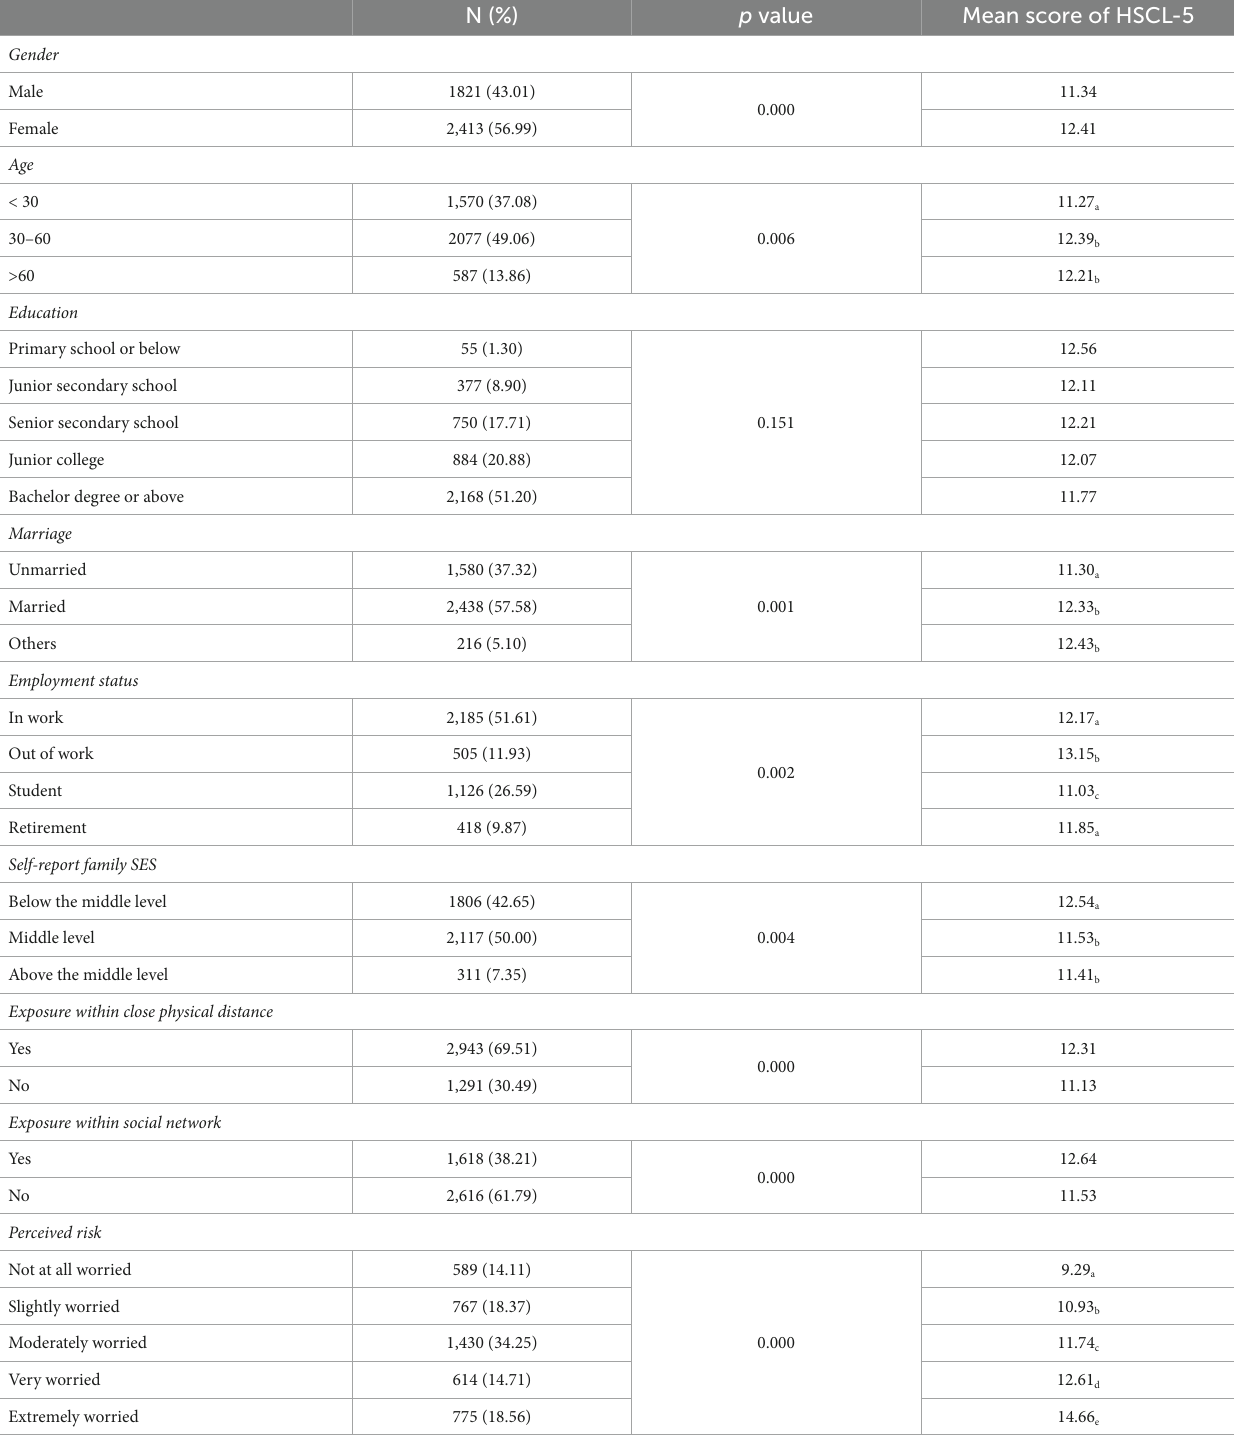
p -values in the third column were obtained by T -test (for binary variables: gender and two exposure factors) and ANOVA (for multinomial variables). Subscripted lowercase letters (a, b, c, d, e) in the fourth column represented the results of pairwise comparisons of the mean total score of HSCL-5. The same letters meant that the difference between any two disparate groups in one category was not statistically significant, while the different letters meant significant differences at 0.001, 0.01, or 0.05